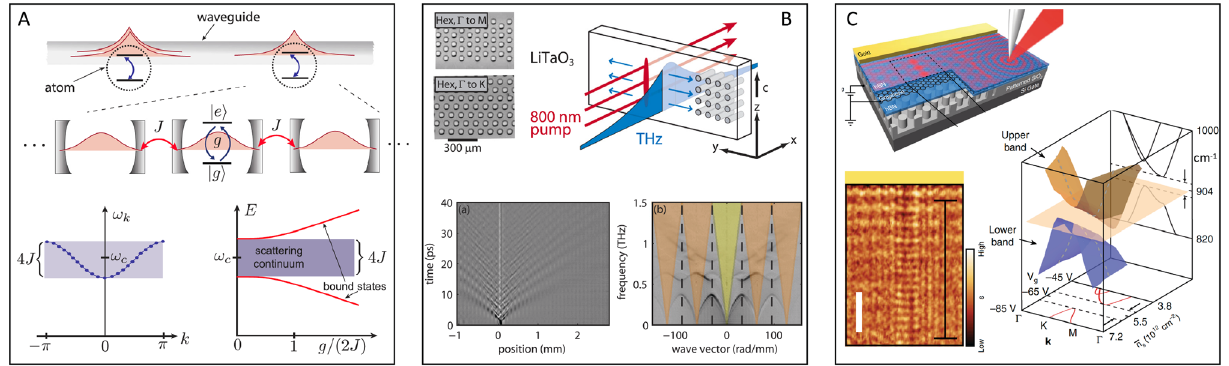
Figure 11: Polariton waveguide QED. PanelA:emergenceof boundatom – photondressedstatesin1Dwaveguides with finitebandwidth.The slow-lightwaveguidecanbemodeled as a large array of coupled optical resonators with nearest-neighbor coupling J. Lower left: band structure of the waveguide without atoms. Lower right: single-photon spectrum as a function of the atom – photon coupling g in the case of a single atom (with ω a = ω c ) coupled to the waveguide, showing the emergence of bound states. Reproduced from a study by Calajo et al. [503]. Panel B: Photonic crystal for phonon polaritons in LaTaO 3 . Top left: optical microscope images of the photonic crystal patterns. Top right: schematic of pump – probe experiments. Bottom left: space – time plot of THz waves generated directly inside a square photonic crystal. The edges of the image are the edges of the photonic crystal. Bottom right: dispersion diagram obtained from a 2D Fourier transform of the space – time plot in bottom left panel. The regionhighlightedinyellowrepresentsthelightcone.Theregionshighlightedinorangeshowthelocationsoftheleakymodes.Adaptedfrom astudybyOfori-Okaietal.[504].PanelC:tunableandswitchablephotoniccrystalforsurfaceplasmonpolaritonsingraphene.Top:Schematic of a photonic crystal comprised of a graphene monolayer fully encapsulated by hexagonal boron nitride on top of an array of SiO 2 pillars. Pixelated gate insulator implemented in the form of nanopillars enables the local modulation of the carrier density and therefore of the plasmonic density of states. Bottom left: near- fi eld nano-IR image of plasmonic standing waves for a structure in the top panel. Scale bar 400nm.Bottomright:calculatedplasmonicbandstructureasafunctionofwavevectorkandaveragecarrierdensityns.Averticalcutparallel to the ω – k plane (back panel) generates the plasmonic band structure at fi xed carrier density n s = 5.5 × 10 12 cm 2 . The dashed lines mark the range of a complete plasmonic bandgap. A horizontal cut parallel to n s – k plane (bottom panel) generates the plasmonic dispersion as a function of average carrier density ns and wave vector k , at laser frequency ω = 904 cm − 1 ; a complete bandgap is evident for carrier density around n s = 5.5 × 10 12 cm 2